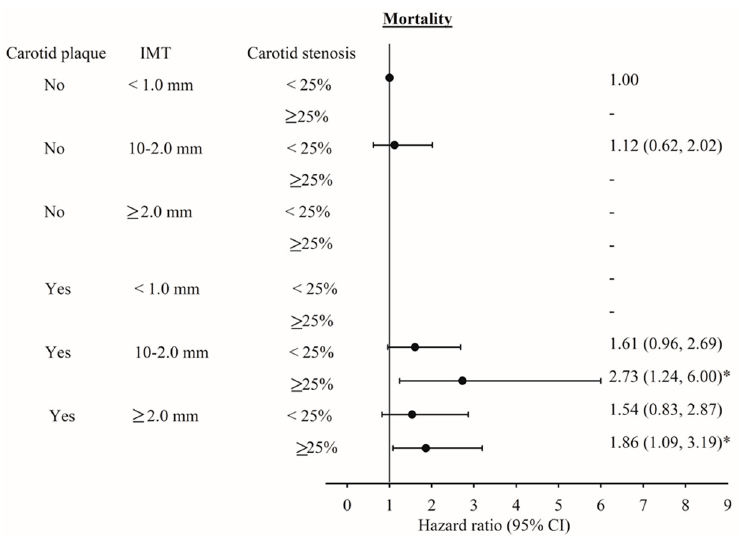
Figure 4. The adjusted HR of mortality the effects of intima–media thickness, carotid plaque, and carotid stenosis. * p < 0.05.